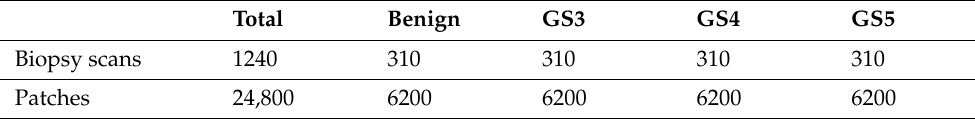
Table 2. Kaggle PANDA Radboud Synthesized Cohort. Total